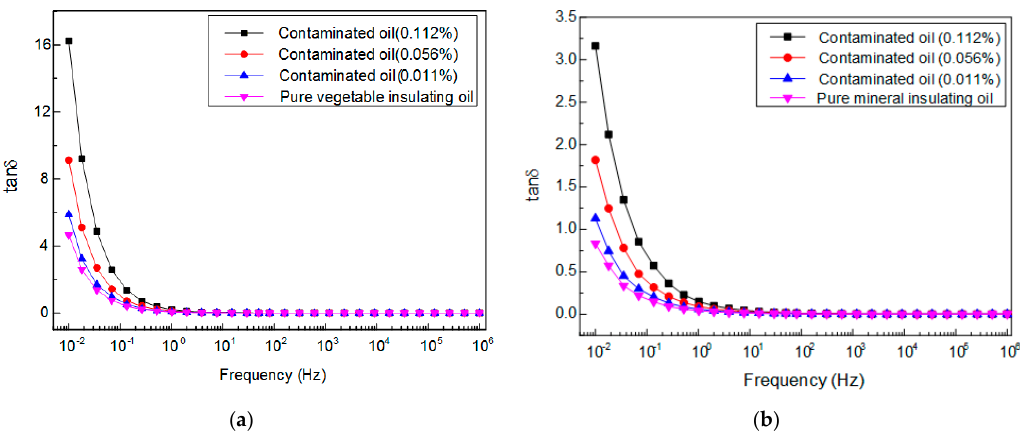
Figure 7. Dissipation factor of ( a ) vegetable insulating oil and ( b ) mineral insulating oil with different copper volumetric concentrations versus frequency.